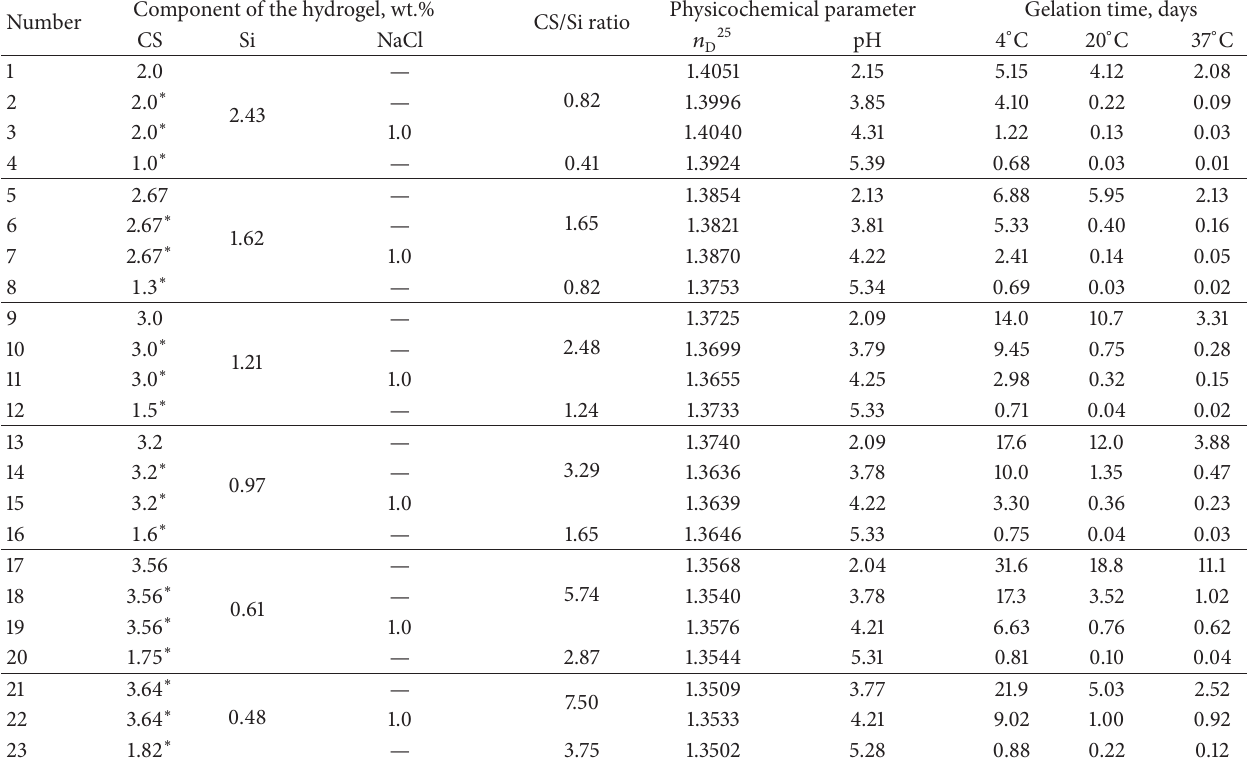
Table 1: Characterization of the hybrid silicon-chitosan-containing